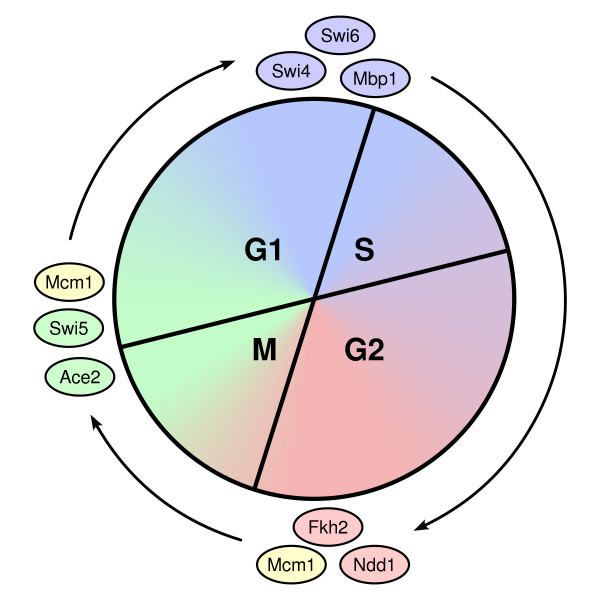
The canonical model of cell cycle regulation. The canonical model is determined primarily from transcription factor binding data. It contains 8 transcription factors that comprise 3 complexes that activate each other in a serial fashion to regulate the expression of genes during the cell cycle.